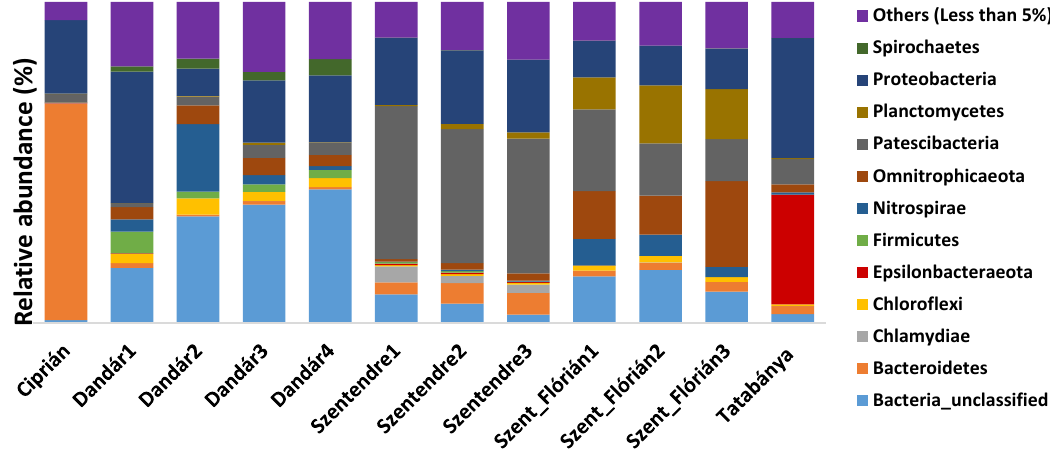
Figure 1. Distribution of the most abundant bacterial phyla based on 16S rRNA gene amplicon sequencing in the water samples. Phyla contributing to less than 5% of each sample are not described.